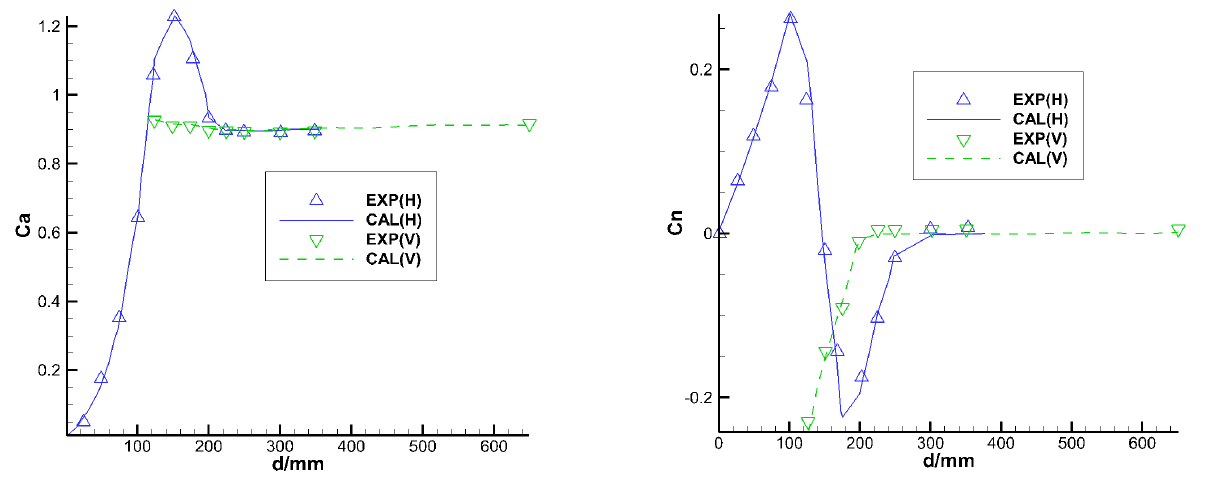
Figure 10. Comparison on aerodynamic coefficients of interfered spherocylinder and spherecylinder obtained by numerical simulation and experiment.